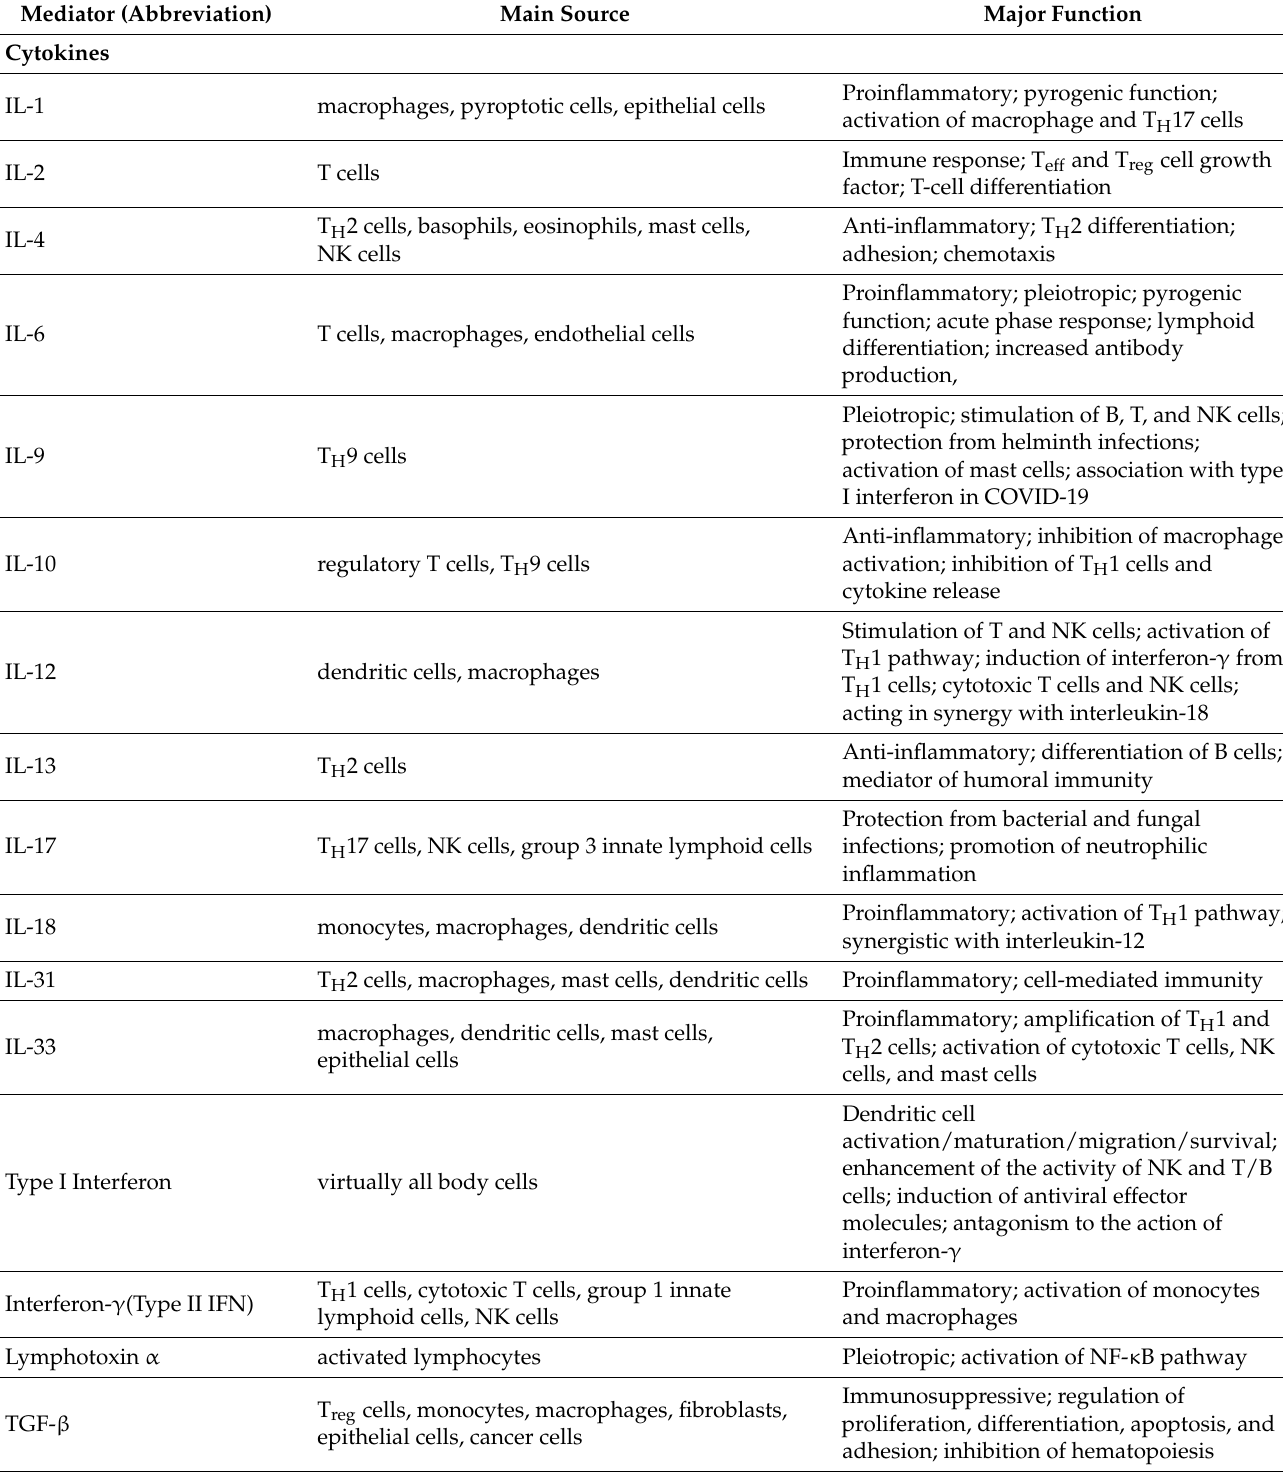
Table 1. Common biomarkers affected during cytokine storm. BLC, B-lymphocyte chemoattractant; CCL, chemokine ligand; CRP, C-reactive protein; CXCL, CXC motif chemokine ligand; IL, interleukin; IP-10, IFN-gamma-inducible protein 10; MCP-1, monocyte chemoattractant protein-1; MIG, monokine induced by IFN-gamma; MIP-1, macrophage inflammatory protein 1; NK cell, natural killer cell;